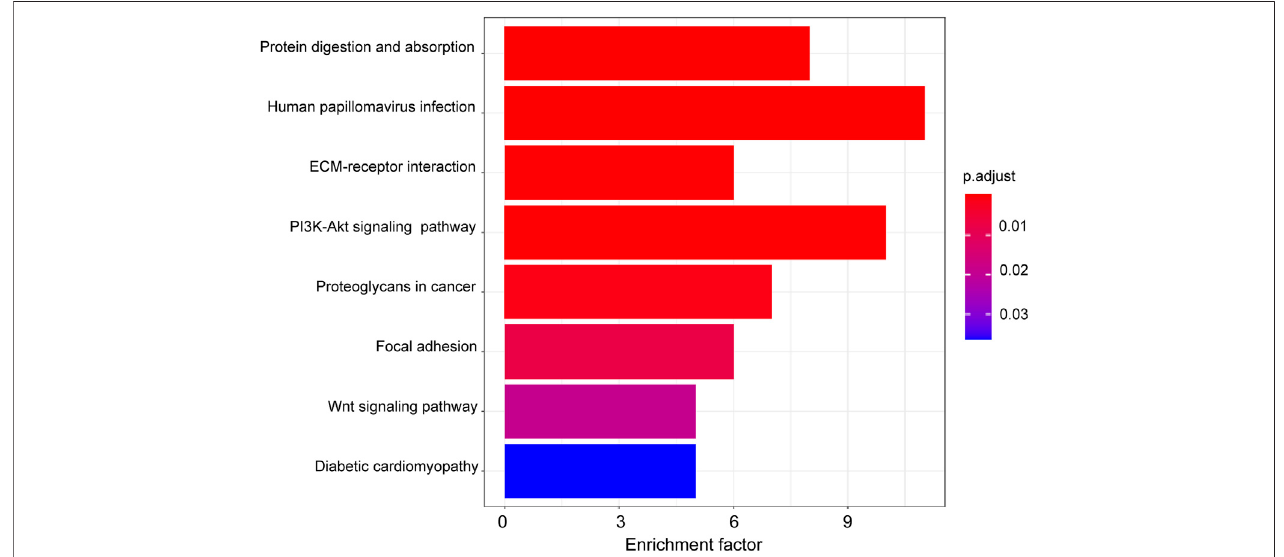
FIGURE4| KEGGanalysisofthedownregulatedgenesbetweenLGG-P and LGG-R. TheDEGswere mainlyenriched inprotein digestion and absorption,human papillomavirus infection, ECM-receptor interaction, PI3K-Akt signaling pathway, and proteoglycans in cancer pathways.